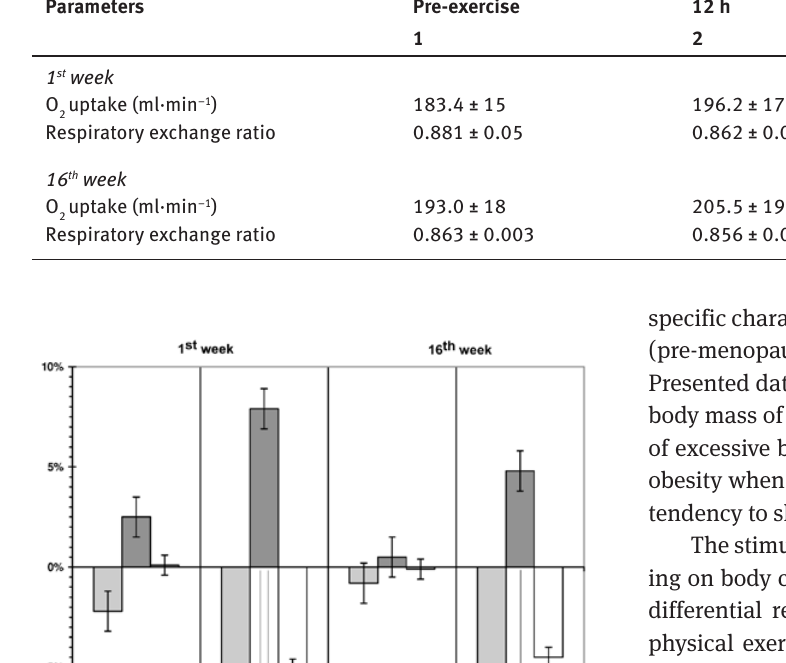
Table 6: Oxygen uptake and resting respiratory exchange ratio at 12 and 36 h after aerobic training session ( n = 8). Parameters